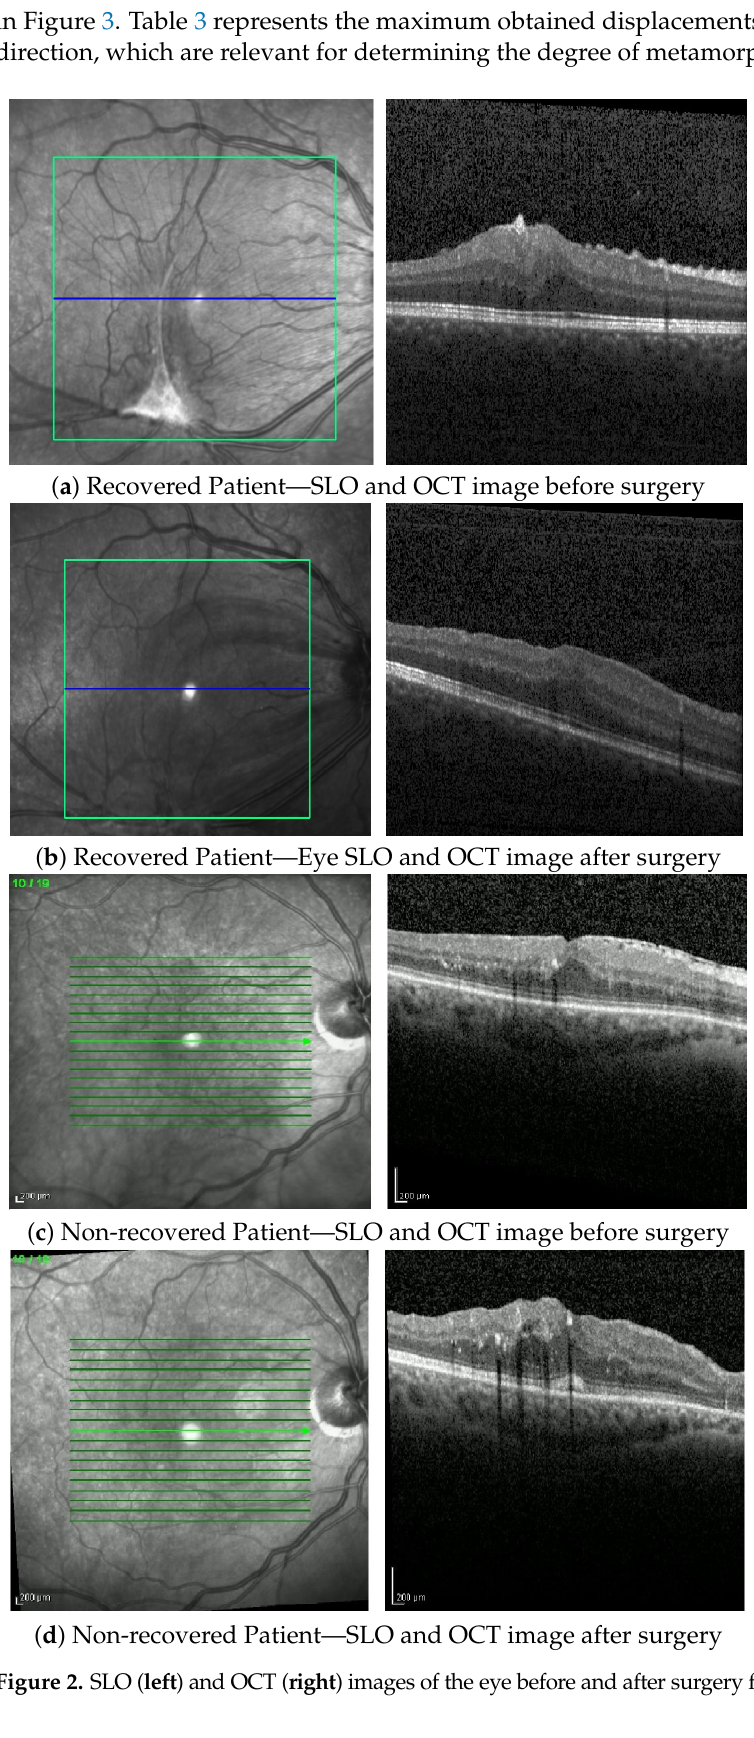
Figure 2. SLO ( left ) and OCT ( right ) images of the eye before and after surgery for the selected